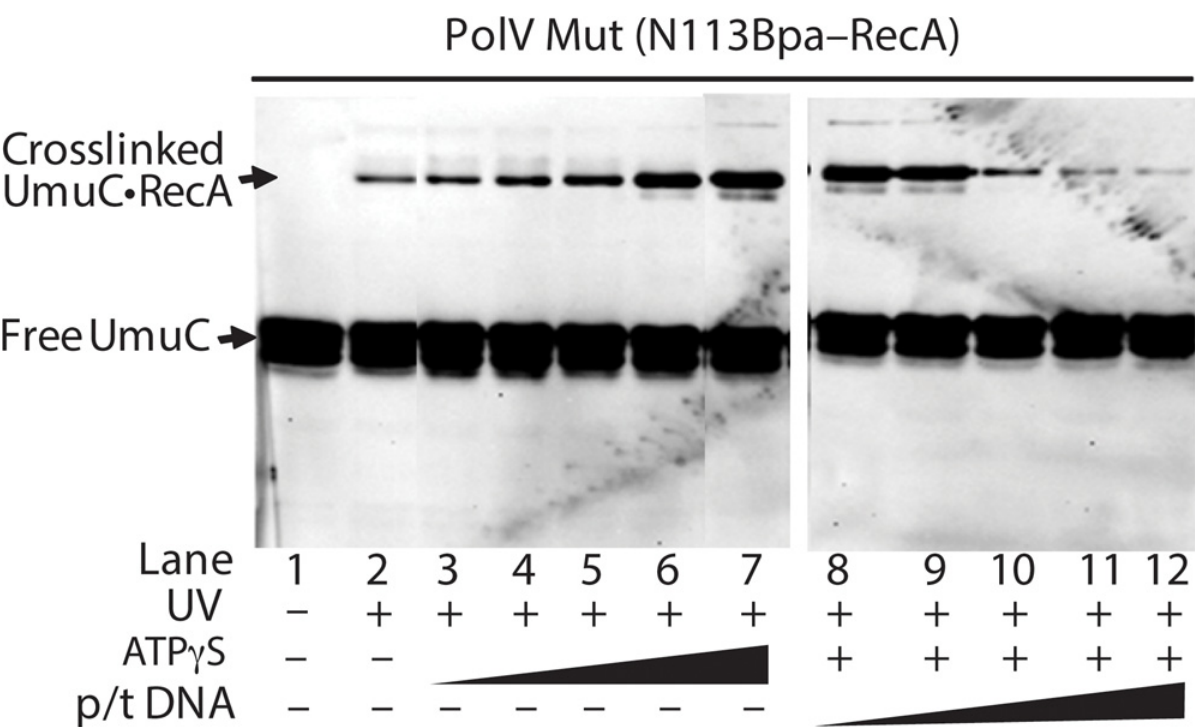
Fig 11. Effects of ATP and primer-template binding on RecA-UmuC cross-linking efficiency in pol V Mut. Western blot using an antibody to UmuC demonstrating increased UmuC-RecA cross-linking with increasing ATP γ S concentration and decreasing UmuC-RecA cross-linking with increasing primer- template concentration in the presence of 500 μ M ATP γ S. pol V Mut was generated using RecA N113Bpa as described in Methods, with ATP γ S and primer- template hairpin DNA added where indicated. ATP γ S concentration ranges from 0.8 to 500 μ M and primer-template DNA concentration ranges from 0.01 – 5 μ